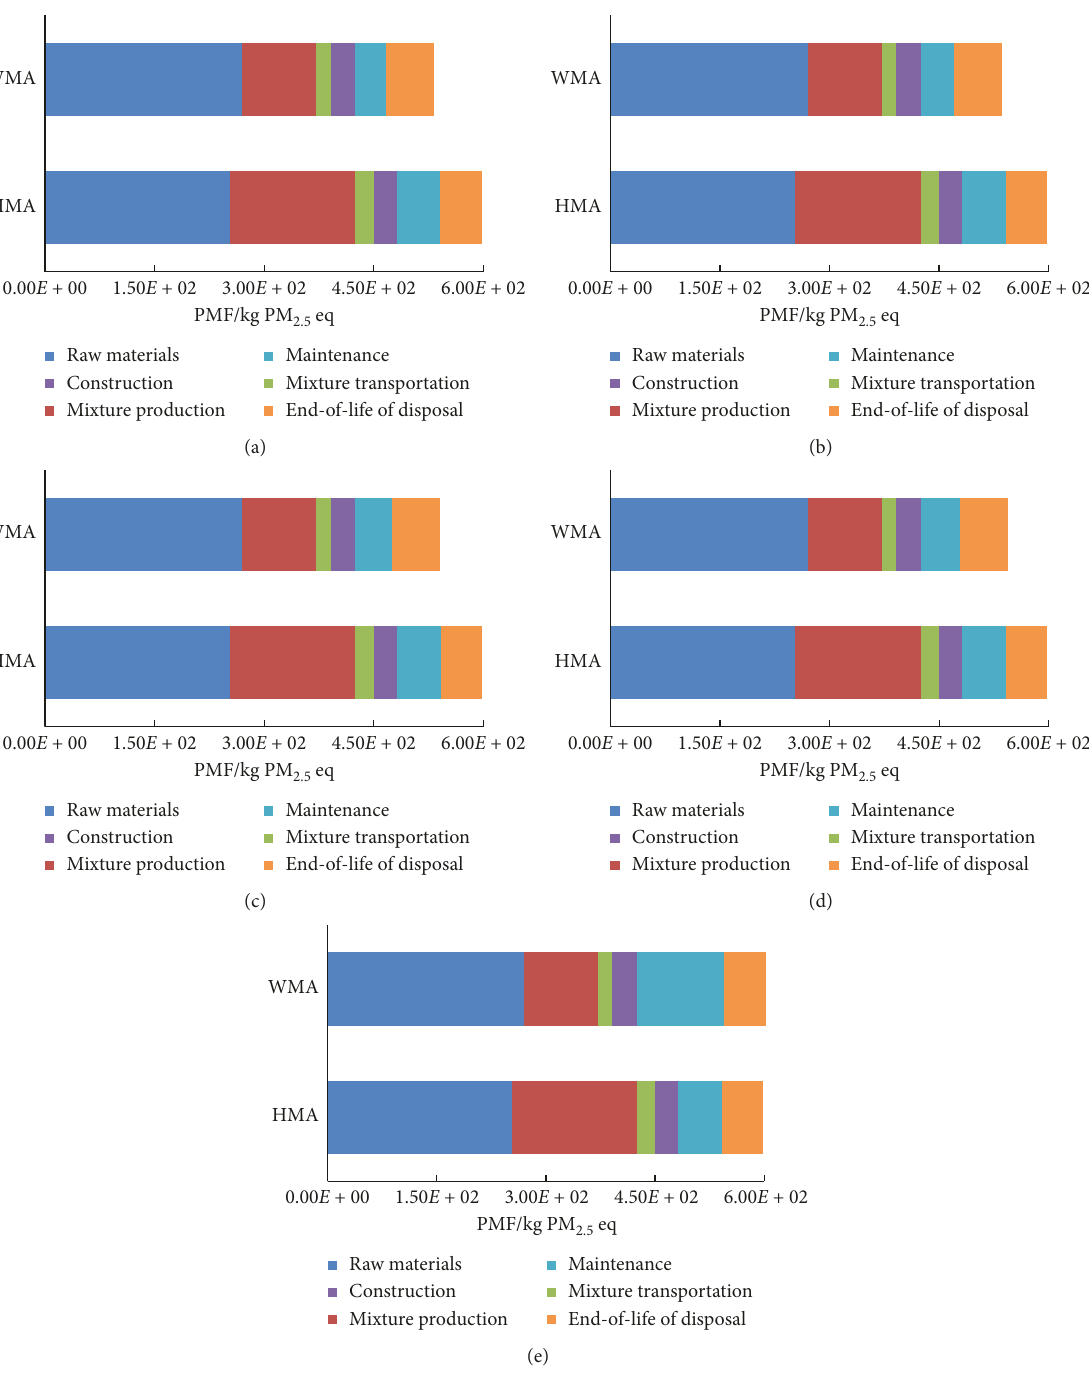
Figure 7: The PMF impacts of HMA and WMA pavements for five cases: (a) case 1; (b) case 2; (c) case 3; (d) case 4; and (e) case